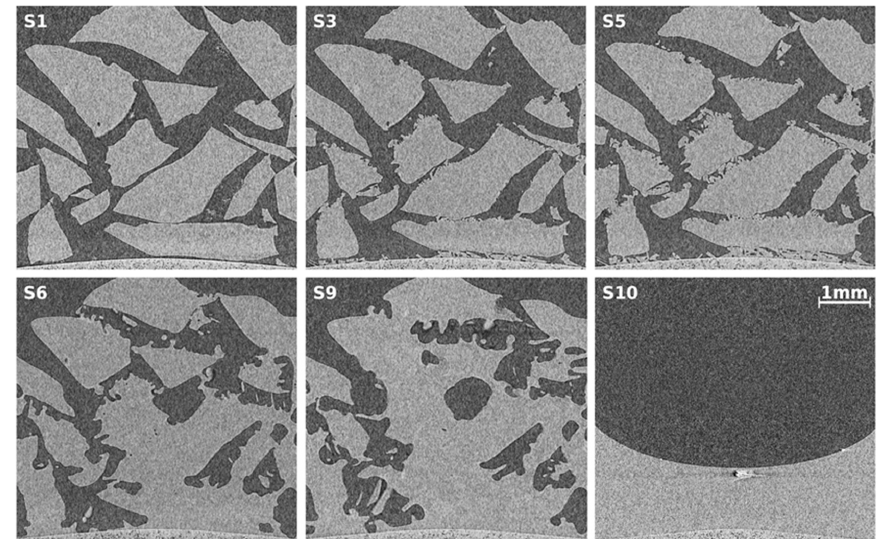
Figure 4. Tomographic images obtained from CT scans (numbered S1, S3, S5, S6, S9, and S10) of the ice sample at different points in time. Each slice represents the exact same position in space. In S1–S5 the sample temperature is 243 K, while in S6–S9 it is 270 K. S10 shows the meniscus of the molten sample. The bright points in slice S10 stem from tiny metallic particles that produced metal artifacts which had to be corrected manually.